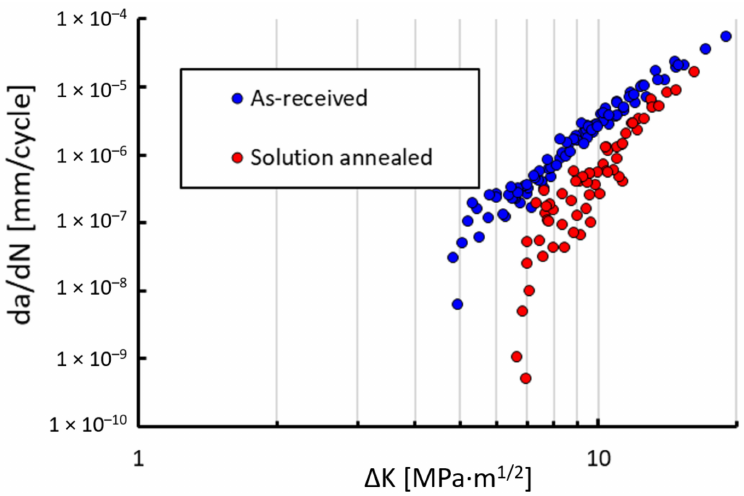
Figure 5. Measured crack growth rates da/dN at the load ratio R = 0.1 for the two microstructural states at room temperature.